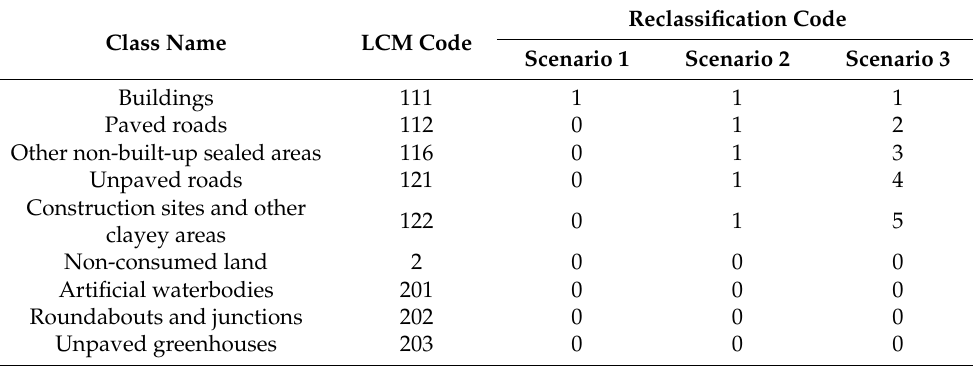
Table 1. LCM reclassification table with respect to the three scenarios. For the first scenario, the class of “buildings” was highlighted; in the second scenario the consumed land classes were separated from natural surfaces; and in the third one, the different consumed land classes were considered separately. Reclassification Code Class Name LCM Code Scenario 1 Scenario 2 Scenario